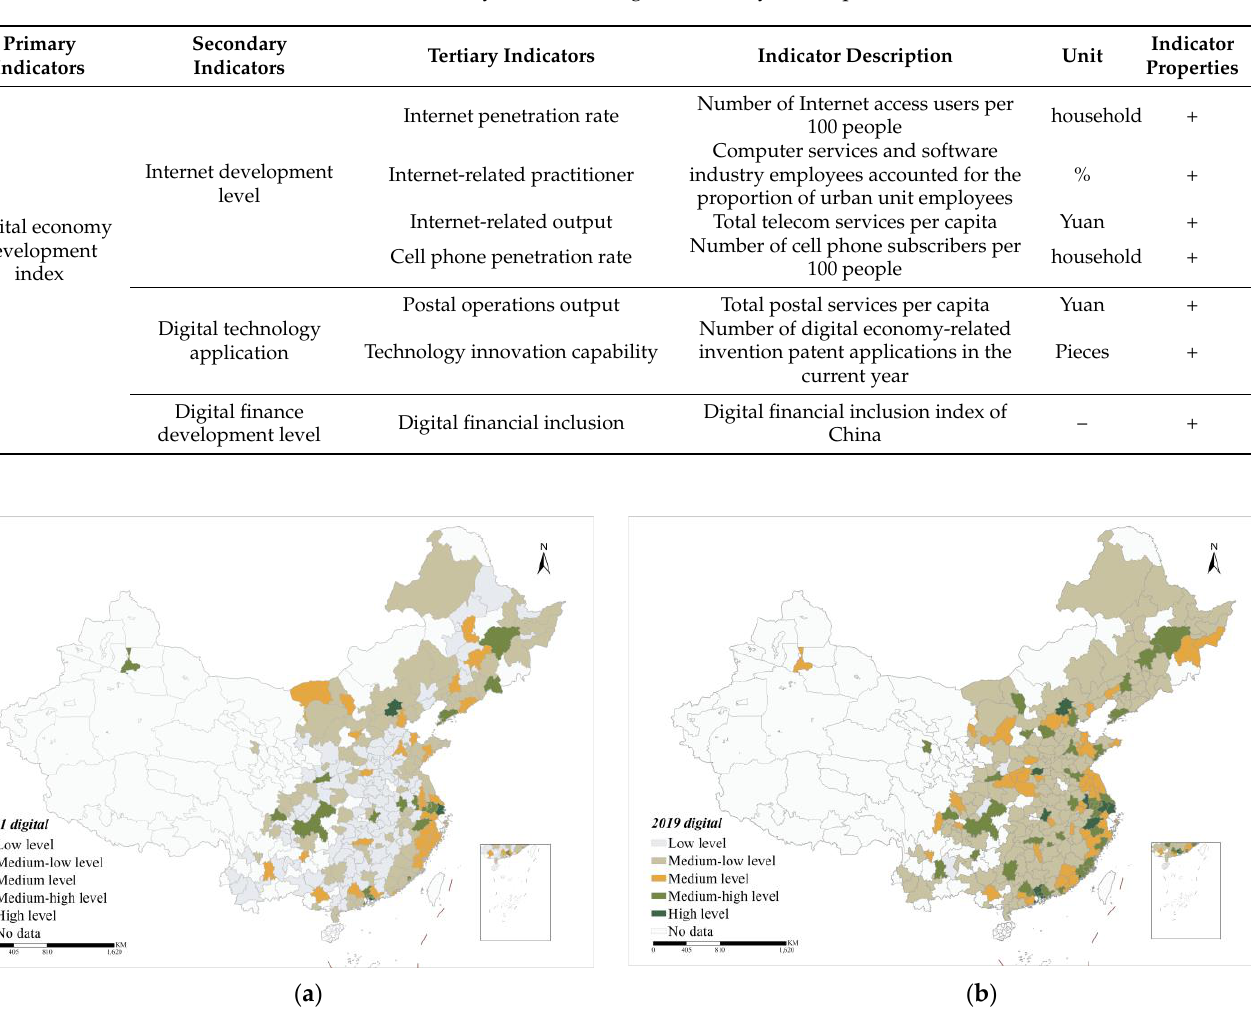
Figure 3. China’s digital economy. ( a ) Spatial distribution in 2011; ( b ) Spatial distribution in 2019.3.2.3. Control Variables